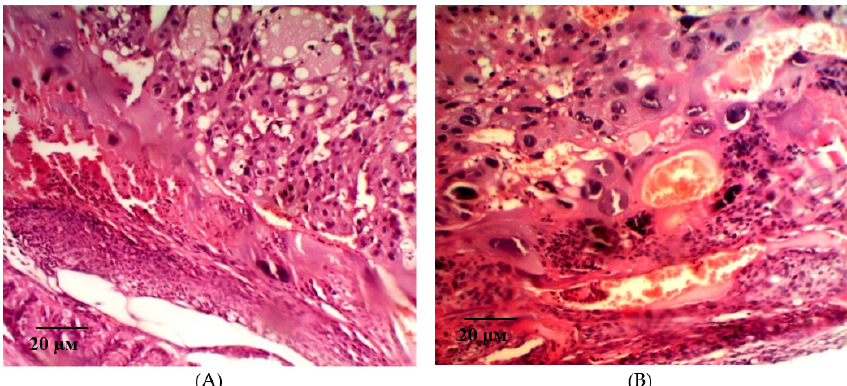
Figure 8. Microphotographs of the maternal placenta on the 21st day of gestation in control animals with ADMA-like preeclampsia. Note: Impaired structure of morphological elements of the placenta. Optically empty decidual cells ( A ). Extensive fields of necrosis and fibrin deposits ( B ). Hematoxylin and eosin staining. Magnification: 400 × ( A , B ).